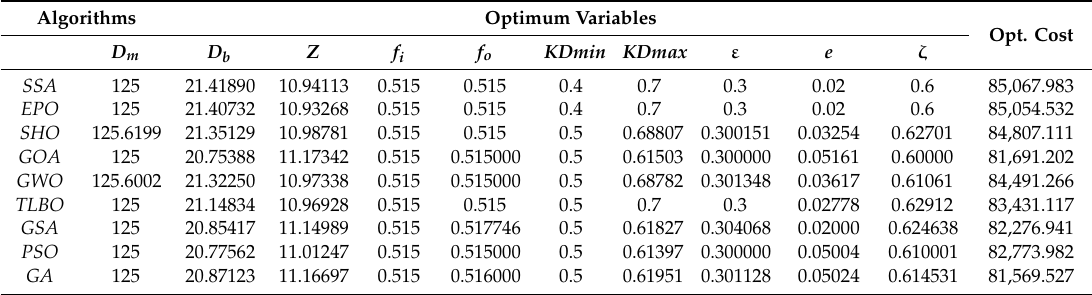
Table 13. Comparison results for rolling element bearing design